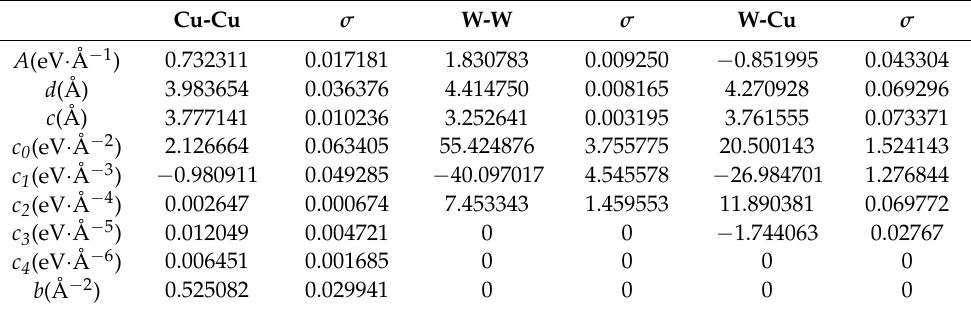
Table 1. Obtained parameters for the Cu-Cu, W-W and W–Cu components of the W-Cu